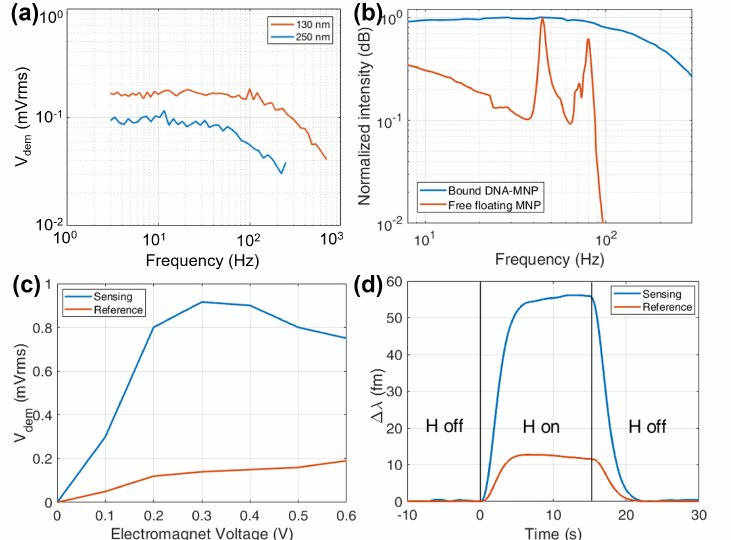
Figure 7. Calibration of the Opto − Magnetic measurements parameters and high precision detection. ( a ) Response comparison between different MNP sizes, the higher mobility favours smaller parti- cles. ( b ) Frequency response comparison for MRR with bound and free MNP, each configuration normalized to its sensing’s maximum. ( c ) Electromagnet voltage calibration to find the optimum signal. ( d ) On − Off Opto − Magnetic signal at 10p M concentration with 0.1Hz bandwidth filter: fast and low − noise